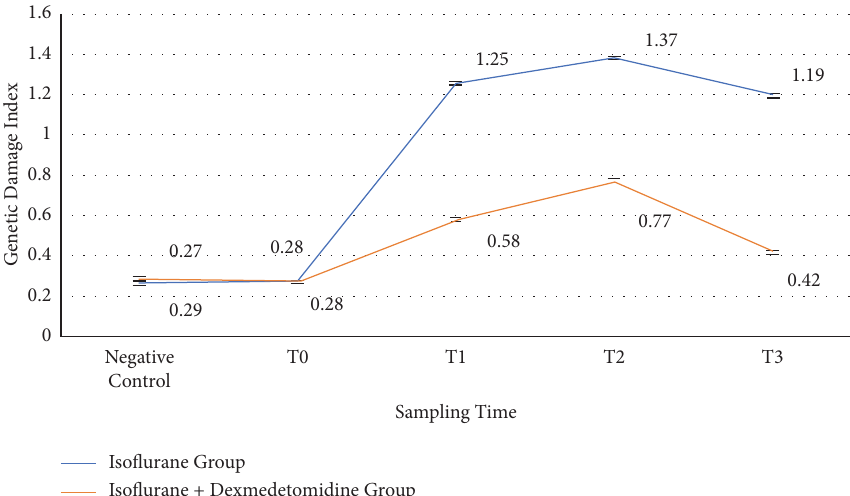
Figure 4: Graphical comparison of the genotoxic potential of ISO alone and in combination of ISO with DEX. T induction (baseline), T 1 � at 4hours after anesthesia induction. T 2 � at 8hours of anesthesia induction, T 3 � at 16hours of anesthesia induction. P < 0 . 001.